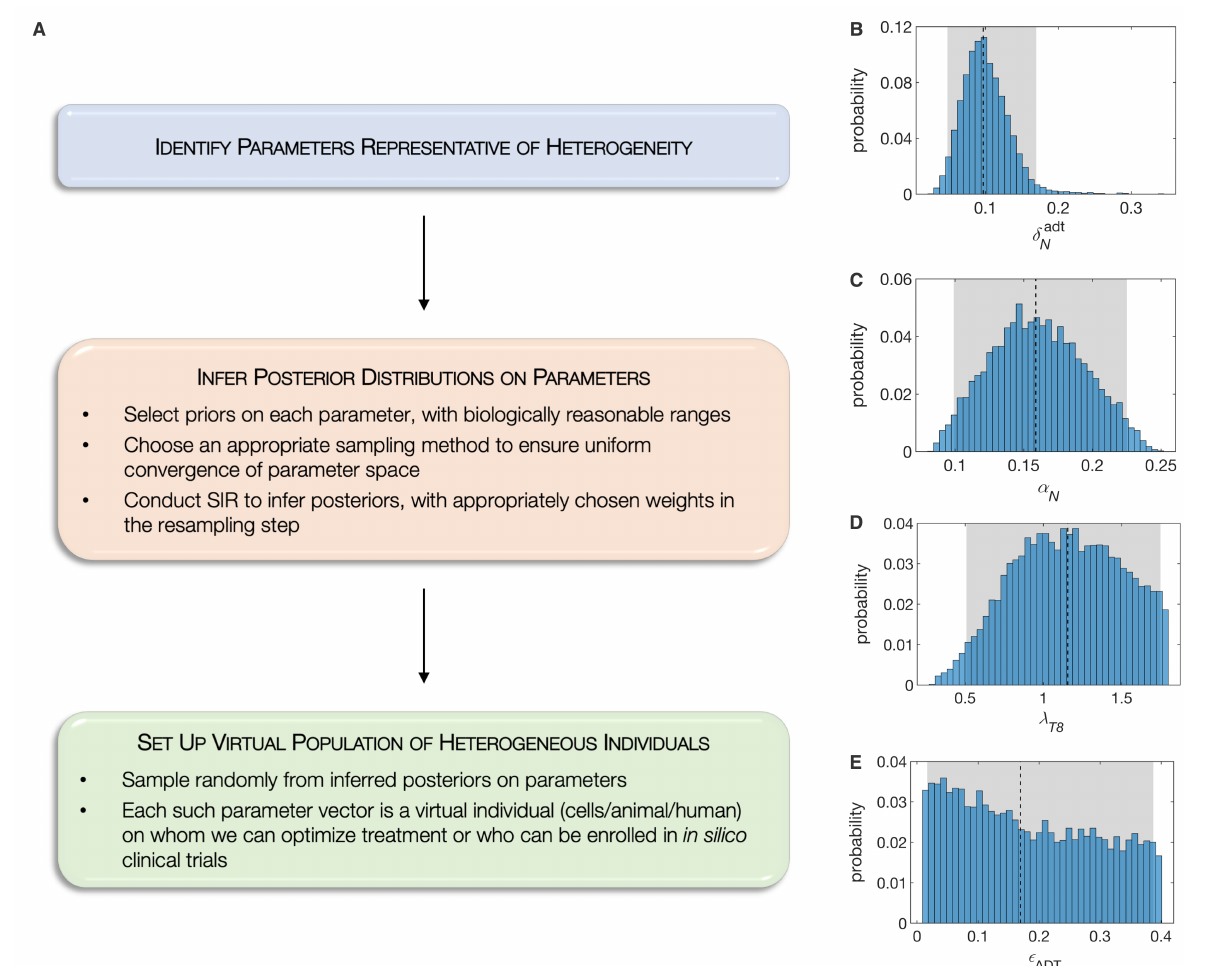
Figure 3. ( A ), The Standing Variations Modeling methodology. Representative inferred posterior distributions of model parameters, namely: ( B ), δ adt , ADT-induced death rate of androgen sensitive cancer cells; ( C ), α N , proliferation rate of N androgen sensitive cancer cell; ( D ), λ T 8 , maximum rate of naïve CD8 + T cell activation by mature APCs; and ( E ), (cid:15) ADT , fraction of ADT-induced cell death that is necrotic. Shown also are 95% confidence bounds (shaded gray areas) and median values (dashed black